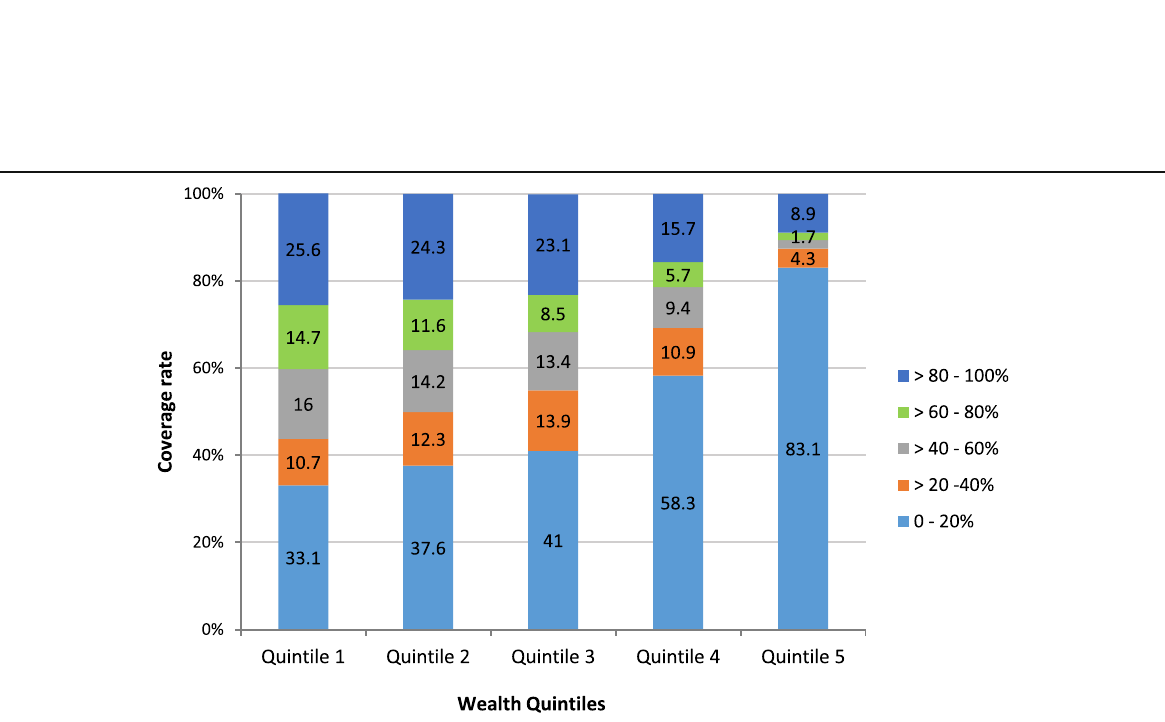
Fig. 1 Number of households in each cluster for the overall population and each quintile. There are 621 total clusters included in this study after initial data processing, with 601 clusters including 20 – 29 households and the remaining 20 clusters including 5 – 19 households for the overall population. Each of the five quintiles included all the clusters that contained at least one household with an asset score in the corresponding quintile. The number of households in each cluster ranges between 1-29 per cluster